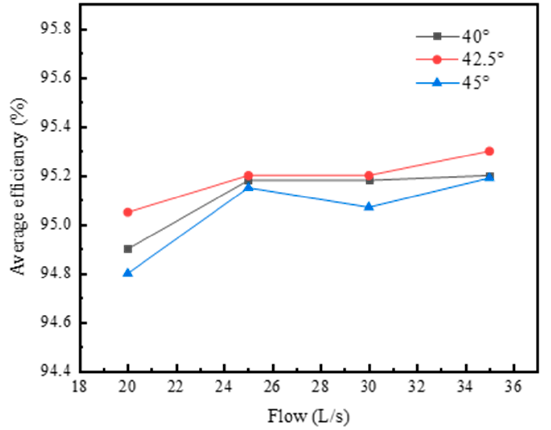
Figure 14. Turbine rotational efficiency at different helix angles.